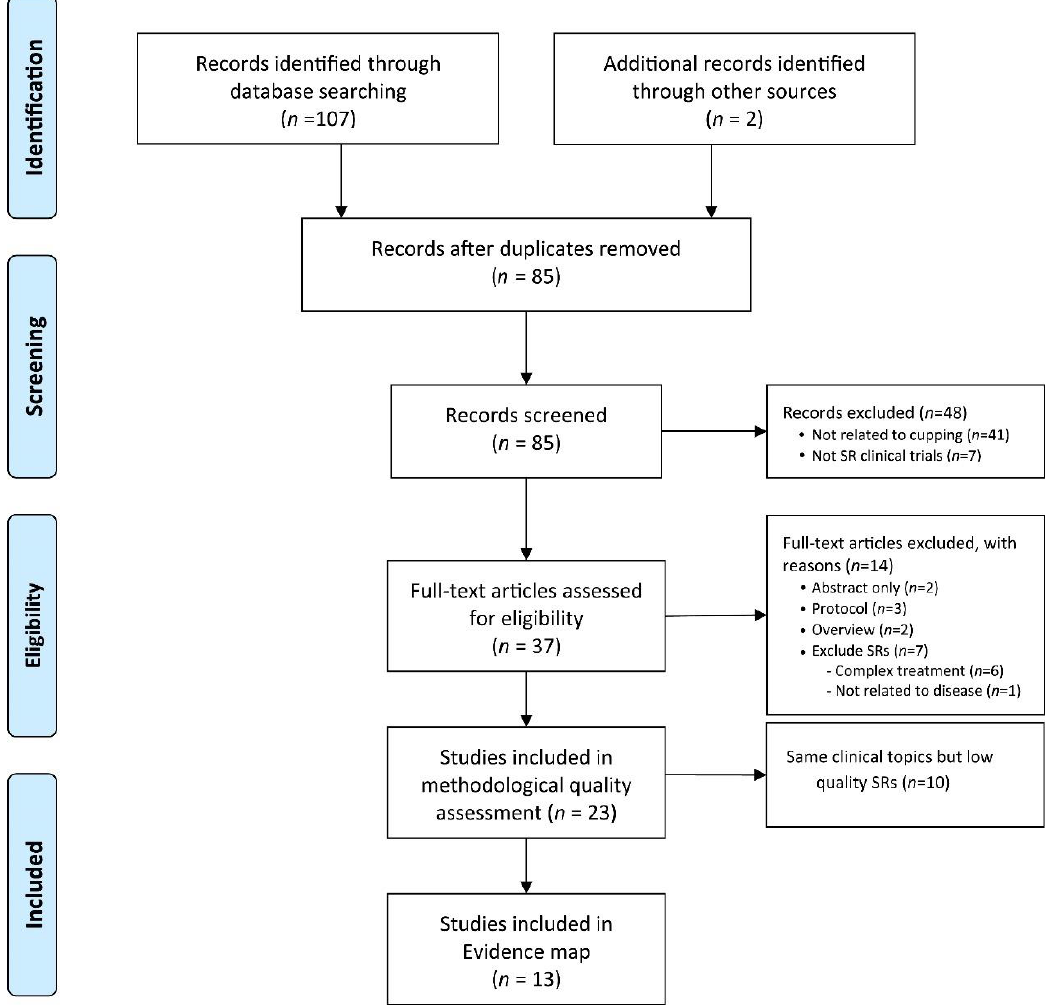
Figure 1. PRISMA diagram for the included studies. SR: systematic review.